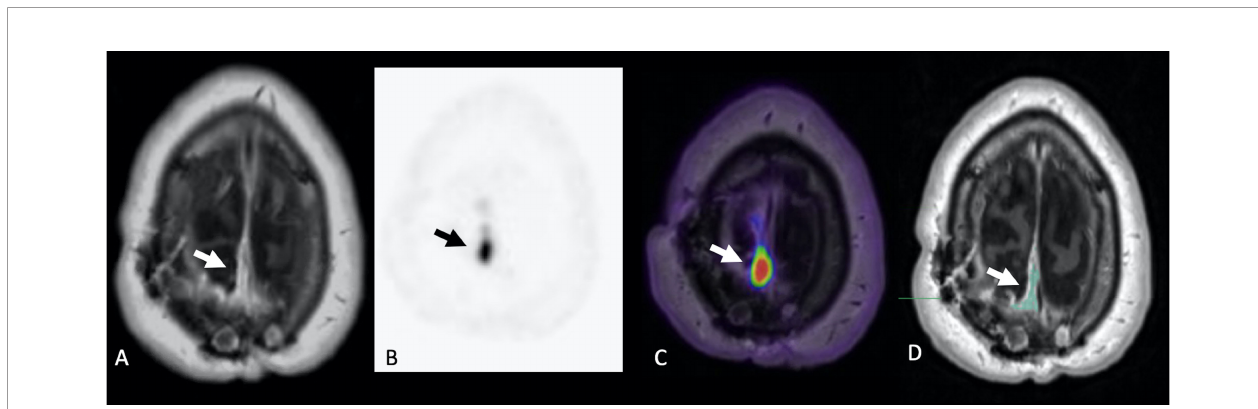
FIGURE 1 | Example of VOI segmentation for DCE analysis in a 56-year-old man with WHO-2 right parietal meningioma post prior surgical resection and RT. Gadolinium-enhanced axial T1-weighted MRI (A) , static 68-Gallium-DOTATATE PET image (B) , and fused axial PET/MR (C) demonstrate extra-axial homogeneously enhancing soft tissue with corresponding 68-Gallium-DOTATATE avidity (arrows), compatible with residual/recurrent meningioma. Gadolinium-enhanced axial T1- weighted MRI with volume of interest (D) is shown, corresponding to region of suspected residual/recurrent